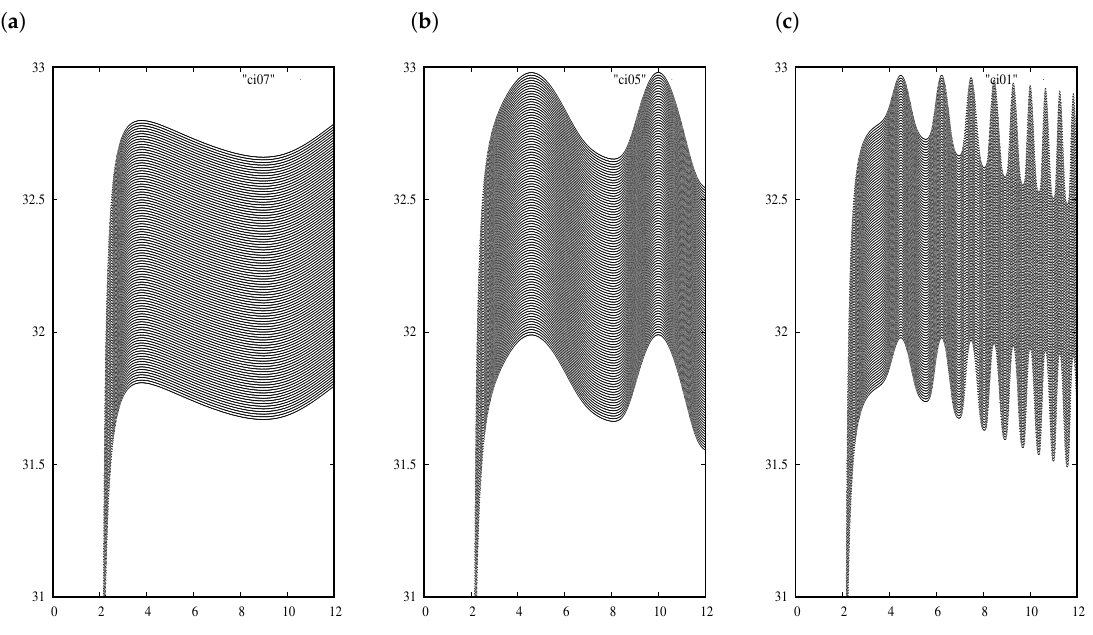
Figure 2. Bifurcation diagram of system 1 with initial conditions (a) 0.7, (b) 0.5, (c) 0.1. Horizontal axis is α and vertical axis is x n , n = 3001 3100.